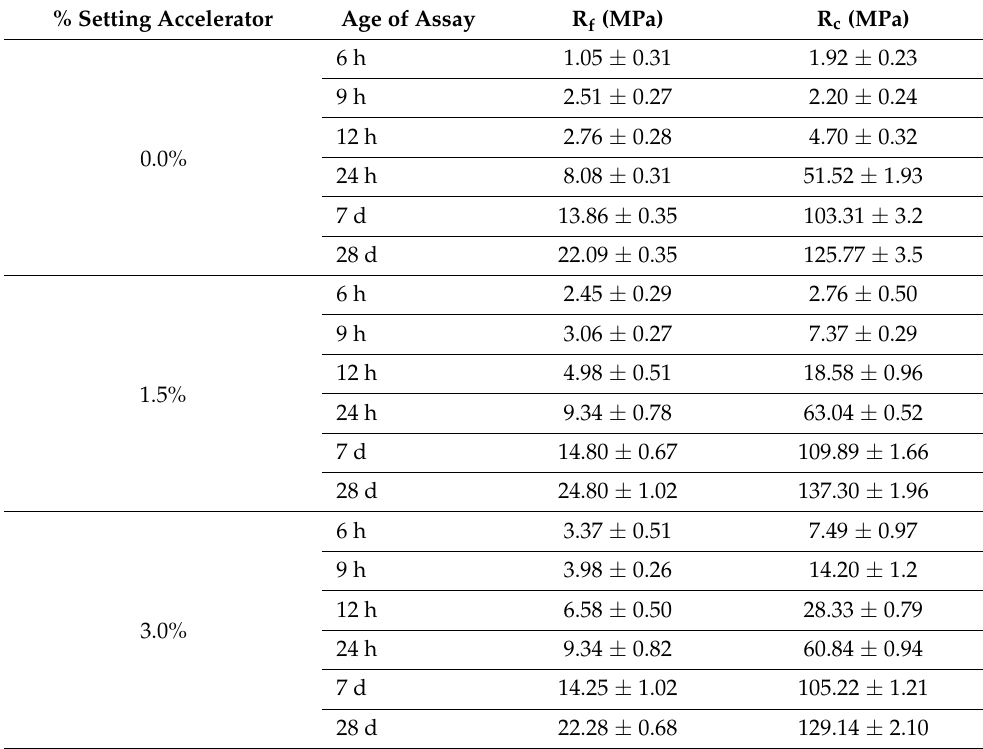
Table 5. Flexural strength (R f ) and compressive strength (R c ) of